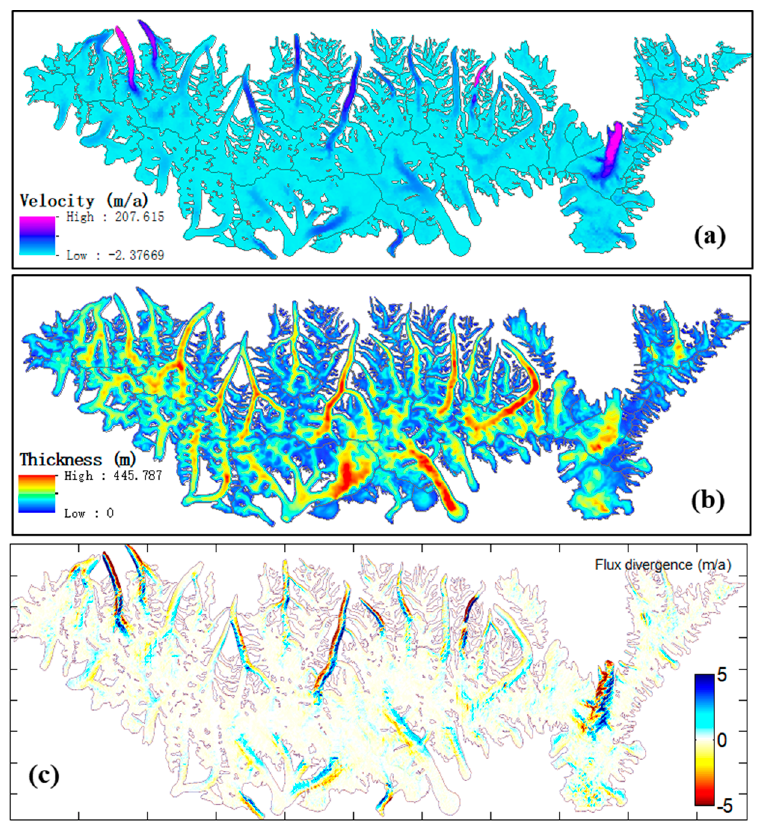
Figure 5. Ice velocity ( a ), thickness ( b ), and ice flux divergence ( c ) of WKM glacier. From the above typical glaciers, we can determine that the uncertainty of the ice flux divergence is mainly derived from the accuracy of the glacier velocity and thickness fields [32]. For example, on the WKM glacier, Millan et al. [33] also provided the glacier thickness fields and showed a specific difference from Farinotti et al. [25] (thickness ranges: 0.00–417.40 m vs. 8.49–998.76 m). The accuracy of each SMB is limited by the overall distribution of the sparse ICESat footprints in the entire glacier. Nonetheless, such sparse ICESat altimetry data provided the possibility to evaluate many glaciers in remote areas. This was unimaginable before the appearance of the ICESat satellite.